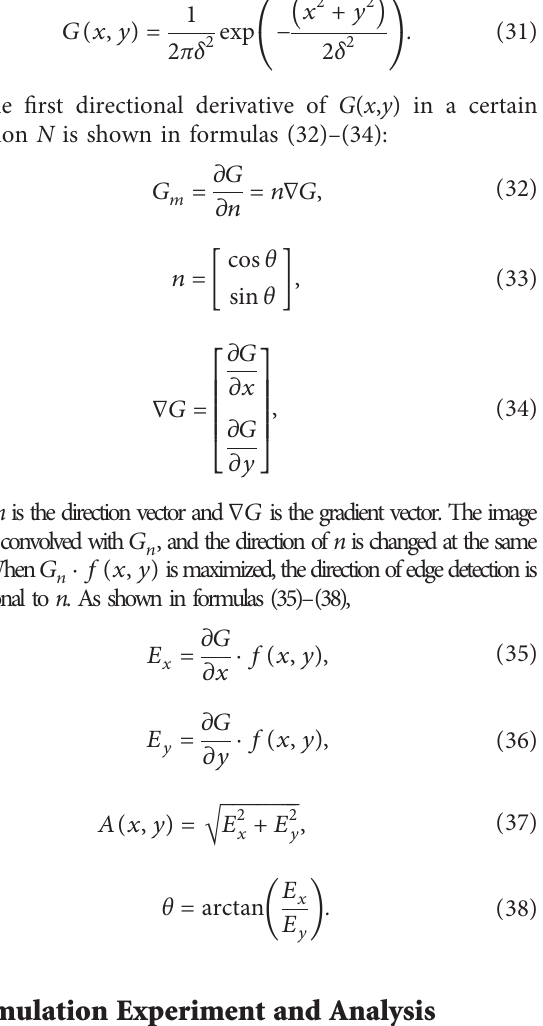
Figure 5. From the results, the gradient matching algorithm is